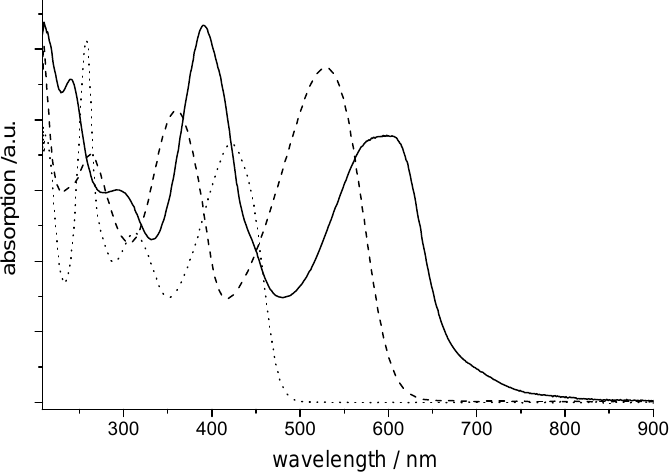
Figure 4. UV-Vis absorption spectra of H 2 L i Pr (dotted line), [Zn 4 (L i Pr ) 4 ] (dashed line), and [Ni 4 (L i Pr ) 4 ] (solid line) in THF.